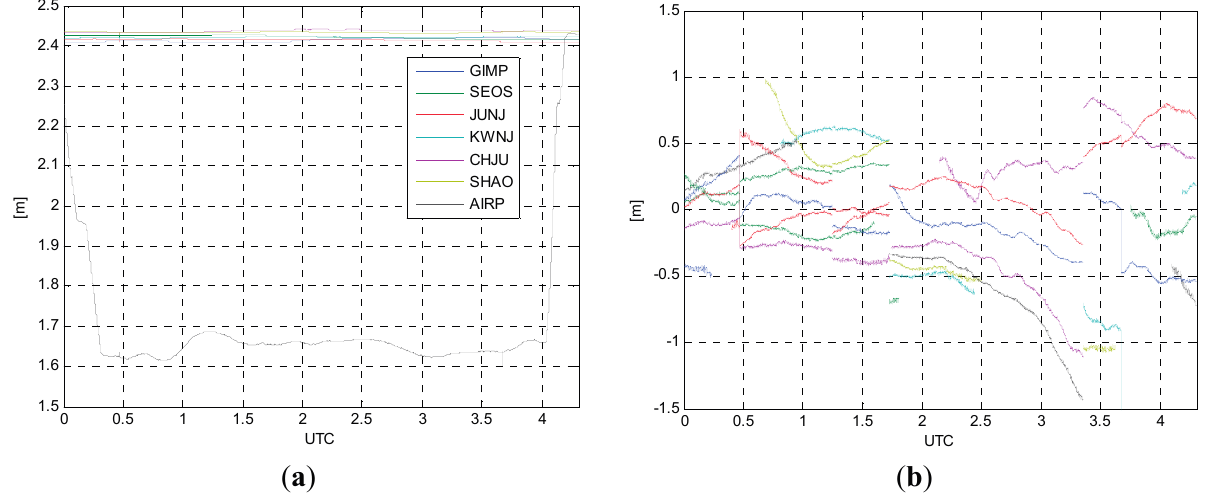
Figure 4. ( a ) Total zenith delays (TZDs); ( b ) DD ionospheric delays for SHAO-AIRP